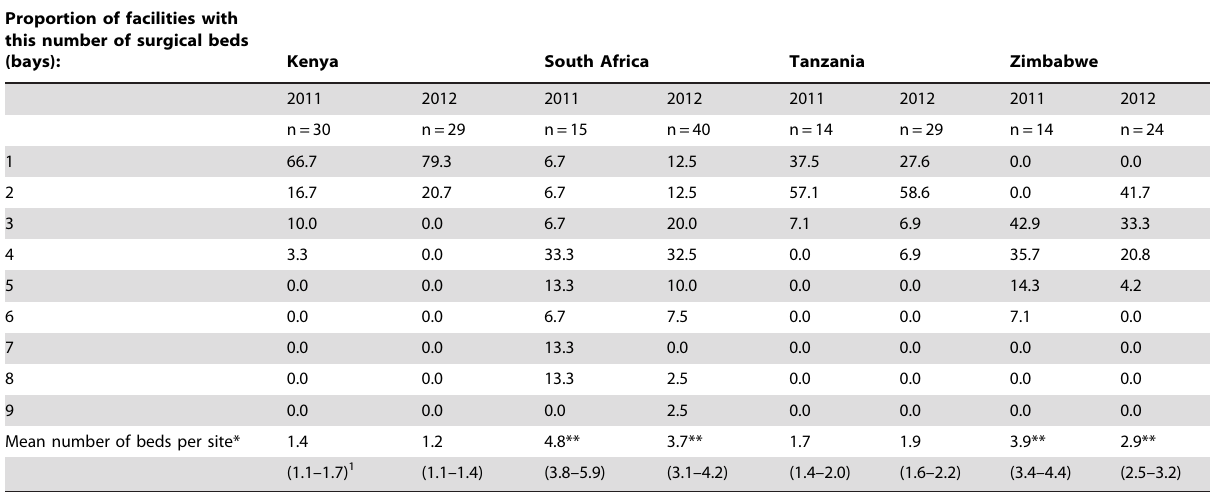
Table 2. Surgical beds per site, by country and by year, based on site assessment.